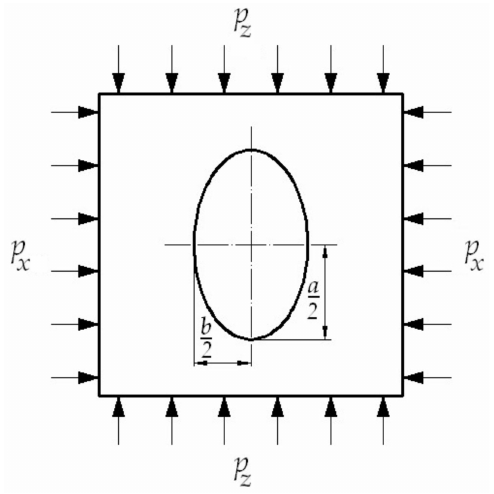
Figure 1. Schematic diagram of the load of a flat plate with an elliptic opening: p x —horizontal component of the primary pressure, p z —vertical component of the primary